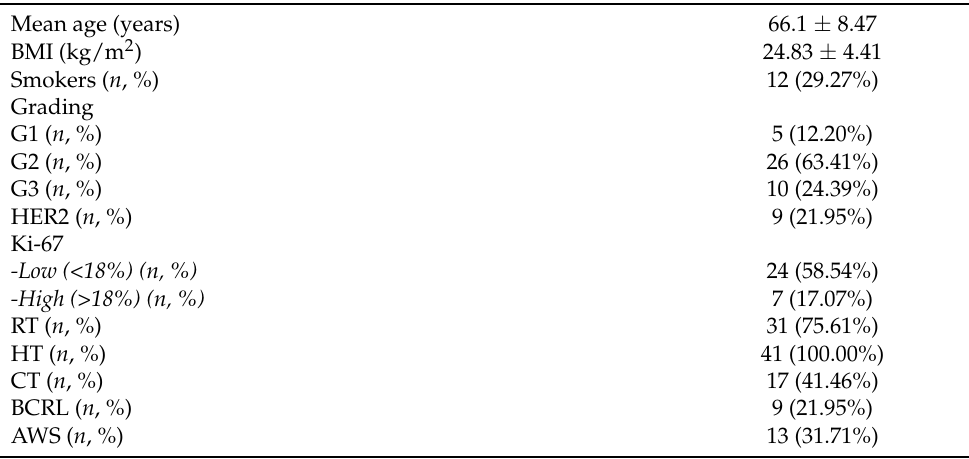
Table 1. Study population characteristics ( n = 41).